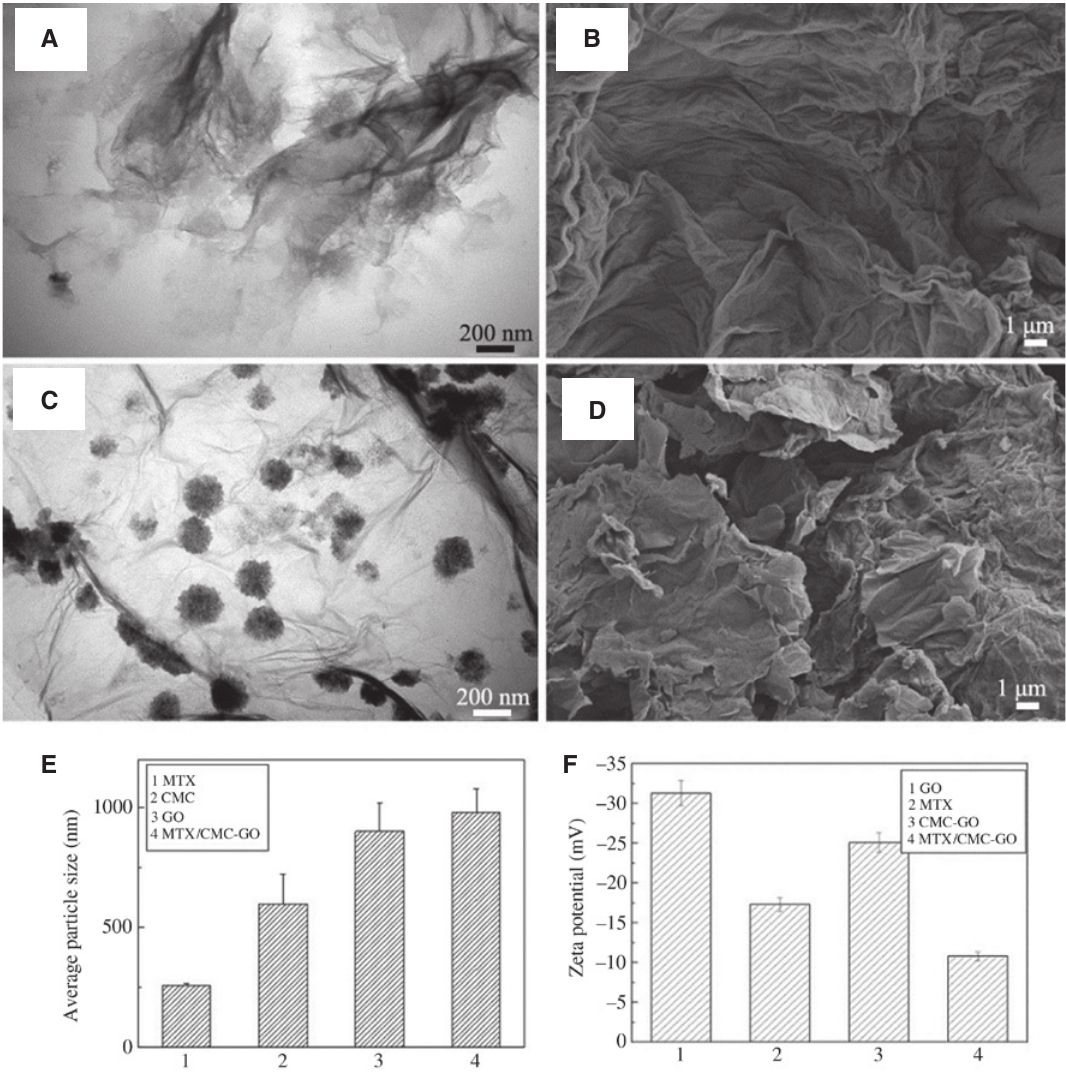
Figure 2: TEM and FSEM images of CMC-GO (A, B) and MTX/CMC-GO (C, D); particle size distribution (E) and zeta potential of each sample